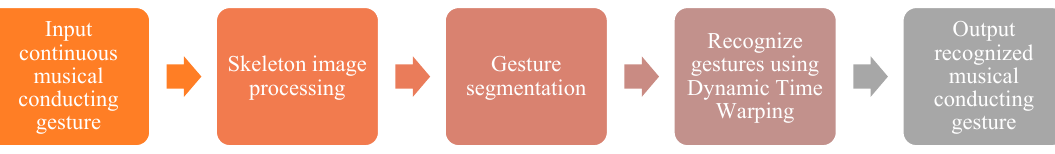
Figure 2. Diagram of our proposed method.